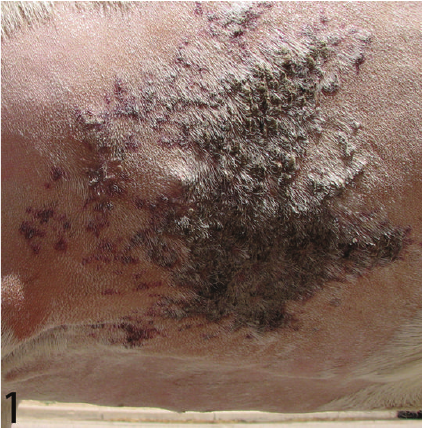
Figure 1: Goat. Gross appearance of the cutaneous mass in situ. Cranial is to the